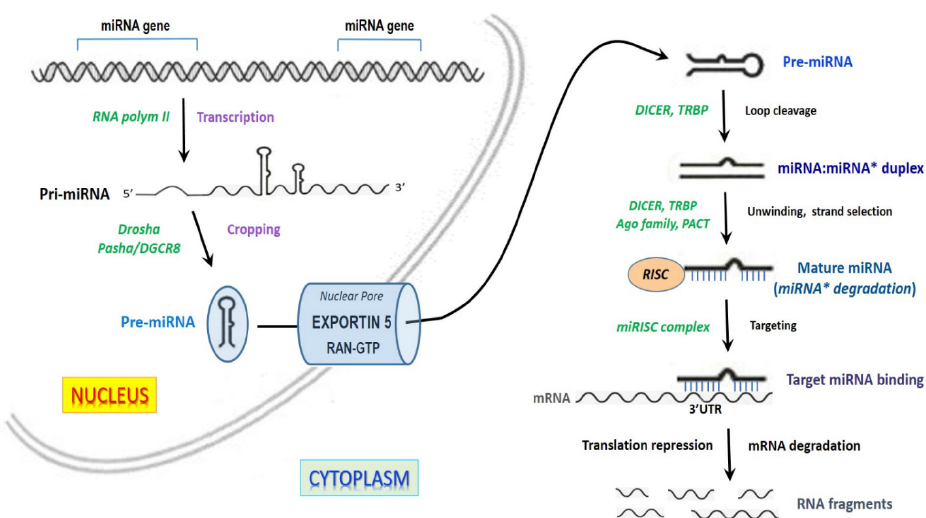
Figure 1. Schematic representation of microRNA (miRNA) biogenesis. In the nucleus, the first event is the miRNA transcription by RNA polymerase II (Pol II). Most genes encoding miRNAs are located in introns and contain their own promoter regions. Following the transcription of long primary transcripts, Drosha, a type III RNase, along with the cofactor Pasha/DGCR8 protein, binds to and cleaves the 3 ′ and 5 ′ strands of the primary miRNA (pri-miRNA) transcript, hence generating the pre-miRNA. Next, the Exportin 5+RAN-GTP complex mediates the shift of pre-miRNAs from the nucleus into the cytoplasm, where the RNase III Dicer and the TAR RNA binding protein (TRBP) cleave the pre-miRNA terminal loop, resulting in a miRNA:miRNA* duplex. The duplex is processed by the argonaute (AGO) proteins family that act in concert with cofactors, such as PACT. This induces the unwinding and the strand selection that drives to miRNA* strand degradation and mature miRNA production. Mature miRNA is in turn incorporated into the RNA-induced silencing complex (RISC) and driven to target mRNAs with complementary sites, resulting in translational repression or mRNA degradation.